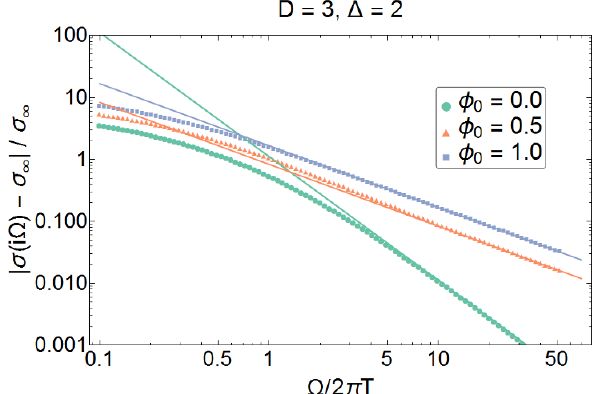
Figure 6 . The real frequency AC conductivities for D = 3 (left) and D = 4 (right) for various choices of scaling dimension (cid:1), with (cid:12)xed (cid:11) W (cid:11) Z = 0 : 1. For D = 3 the sum rules are observed for (cid:1) > 1 : 0 and for D = 4 the sum rules are observed for (cid:1) > 2 : 0. Signi(cid:12)cant enhancement of Re( (cid:27) ) is observed whenever the sum rules are violated.